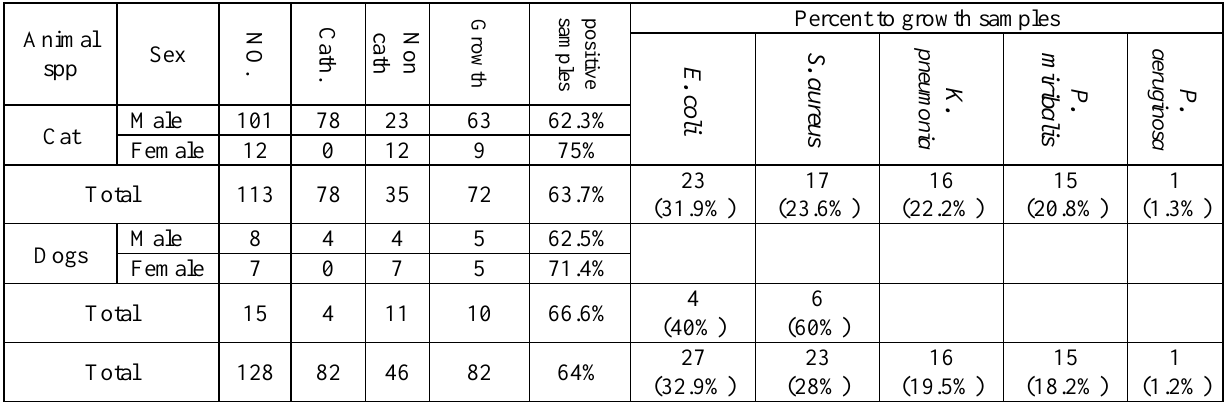
Table 2: The overall incidences of bacterial isolates from urine samples of dogs and cats Animal spp